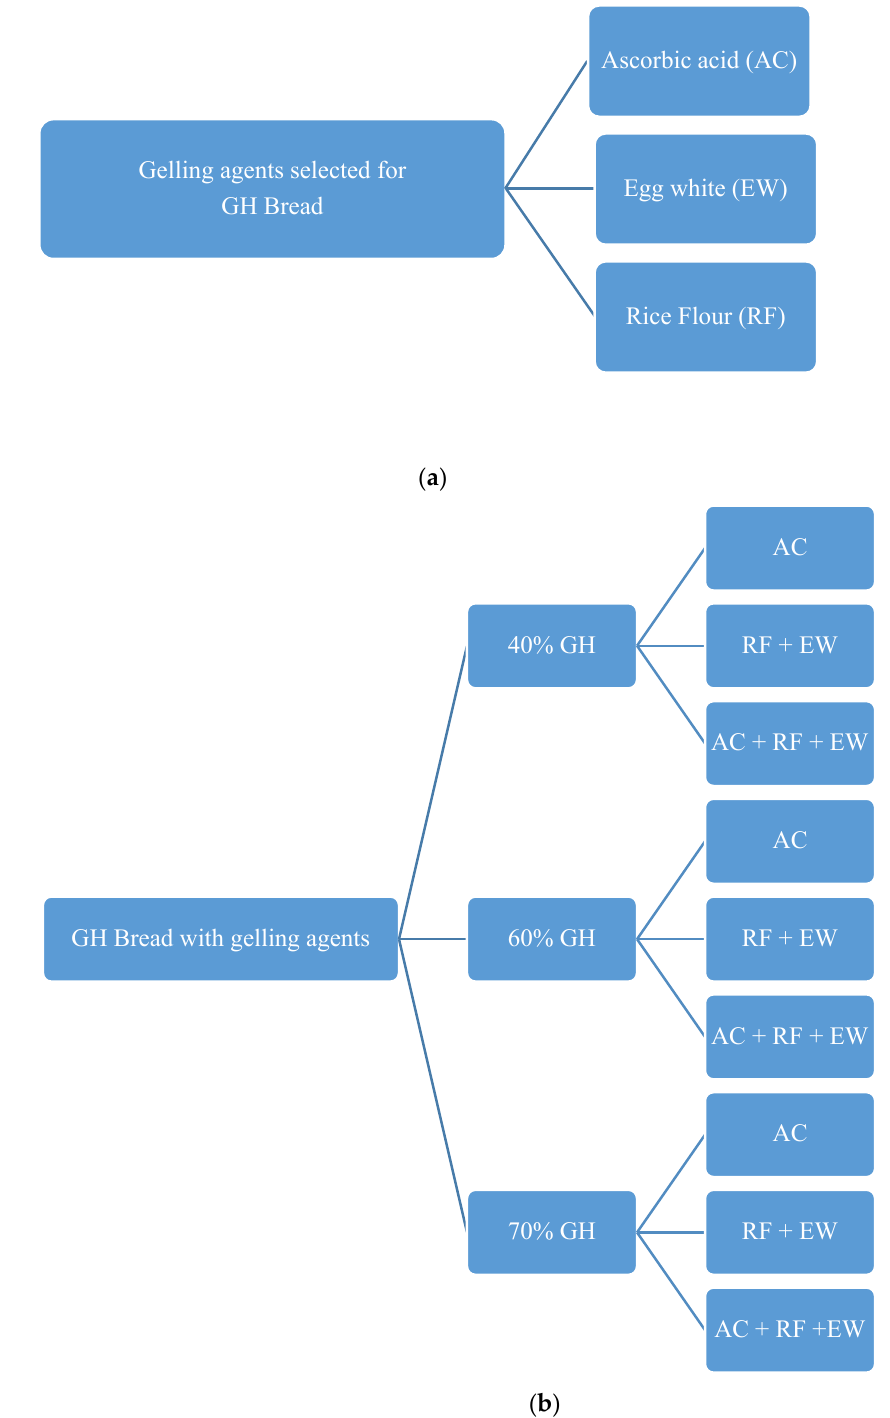
Figure 6. ( a ) The gelling agents selected for the study, and ( b ) variations carried out with gelling agents along with different percentages of GH (40–70%).